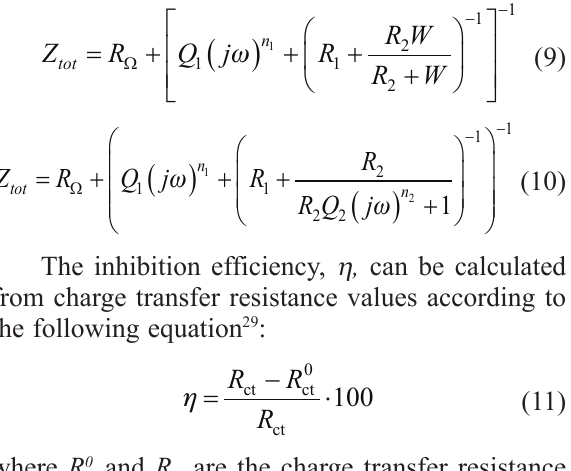
Table 8 – Quantities of Cu ions dissolved during 1­hour im­ mersion of the Cu specimen in acid rain solution at E taining Helichrysum italicum extract obtained from the AAS technique Solution g /g L